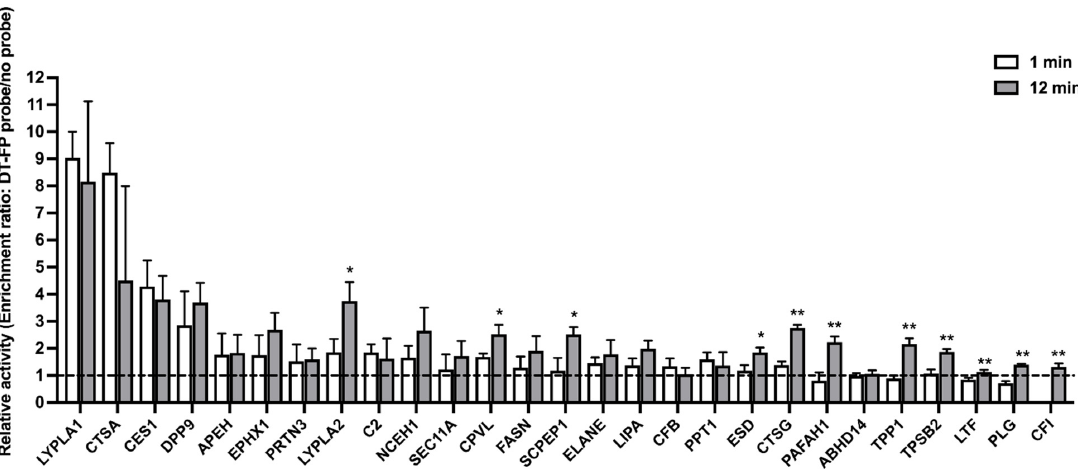
Figure 3. The relative catalytic activity of serine hydrolases in HlungS9. The relative activity was profiled by the enrichment ratio after 1-min and 12-min incubations with the desthiobiotin-FP probe. The enrich ratio of a given hydrolase was calculated by dividing its abundance in the probe treated samples by its abundance in the control samples (without a probe, 1% DMSO). Bars show mean values (±S.D.) of three independent experiments (n = 3), except for LYPLA2 in the 1-min enrichment profile (n = 2). Values below the dashed line (enrichment ratio = 1) indicate no enrichment. * p < 0.05 and ** p < 0.01 indicate statistically significant difference compared with the 1-min incubations (Student’s t -test).